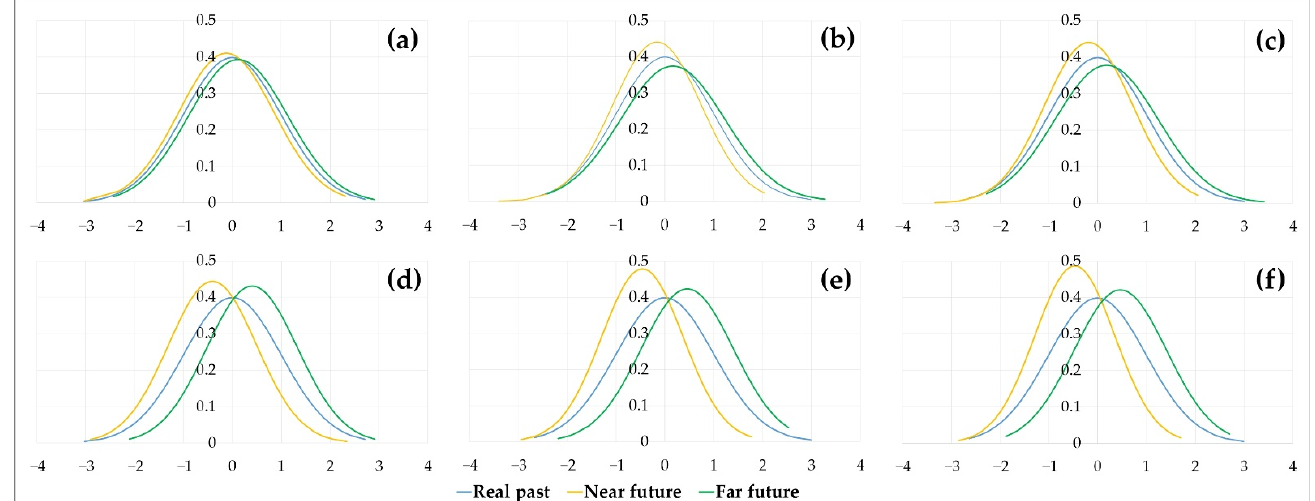
Figure 10. Deviation of SPI index with 12-month accumulation period in: ( a ) Šventoji—Ukmerg ė under RCP 4.5; ( b ) Venta—under RCP 4.5; ( c ) Minija—Kartena under RCP 4.5; ( d ) Šventoji—Ukmerg ė under RCP 8.5; ( e ) Venta—Leckava under RCP 8.5; ( f ) Minija—Kartena under RCP 8.5. Table 5. Changes of SPI (x in Table) according to RCP